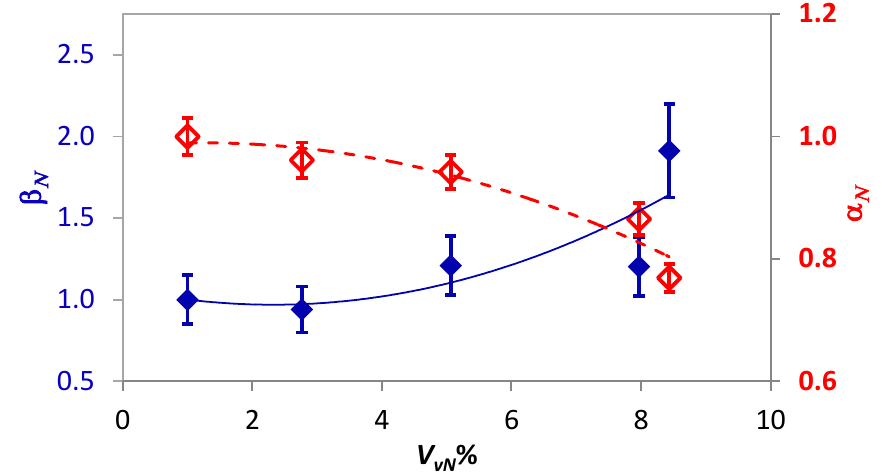
, are in blue with the scale on N , are in red with the scale on the N